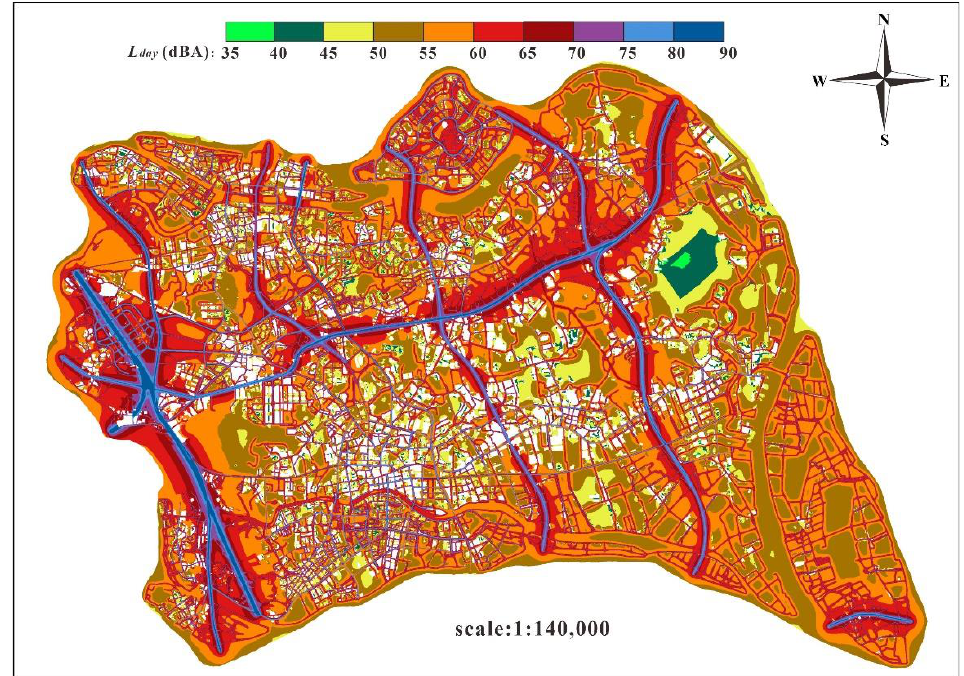
Figure 6. Daytime urban traffic noise map of Panyu District, Guangzhou City with the existence of noise barriers. L day is the A-weighted equivalent noise level over the 16 h period of daytime (6:00 to 22:00).